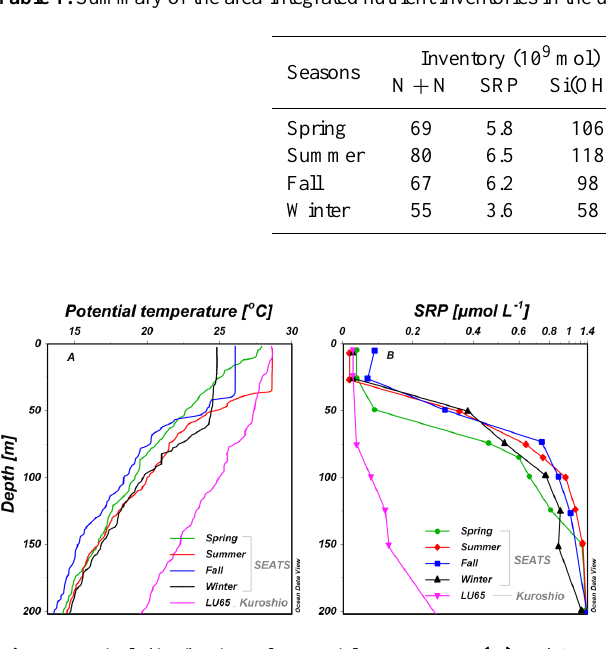
Fig. 4. Vertical distribution of potential temperature (A) and SRP (soluble reactive phosphate, (B) ) in the upper 200m of the water column at the SEATS station in different seasons and station LU65 in